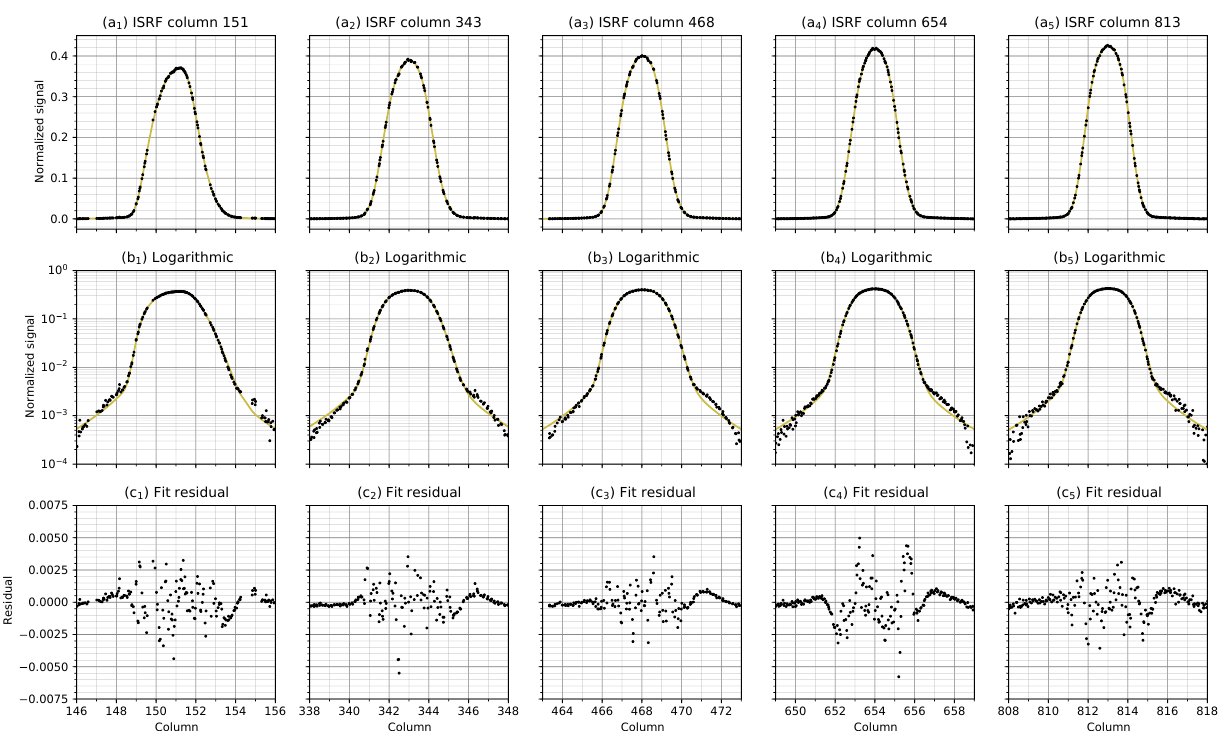
Figure 3. Five typical SWIR ISRFs determined from on-ground measurements with an external laser through the TROPOMI irradiance port. The upper panels (a) show the shapes of the ISRF at location: columns 151, 343, 468, 654 and 813 and rows 24, 76, 118, 155 and 191. The middle panels (b) show the same data on a logarithmic scale. The lower panels (c) show the difference between the ISRF data points and the ISRF fit (end of stage